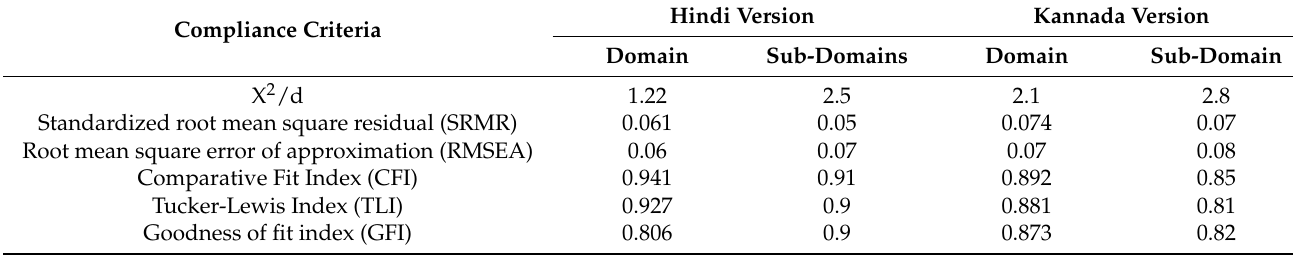
Table 1. Fit indices of measurement model for the Indian versions of the